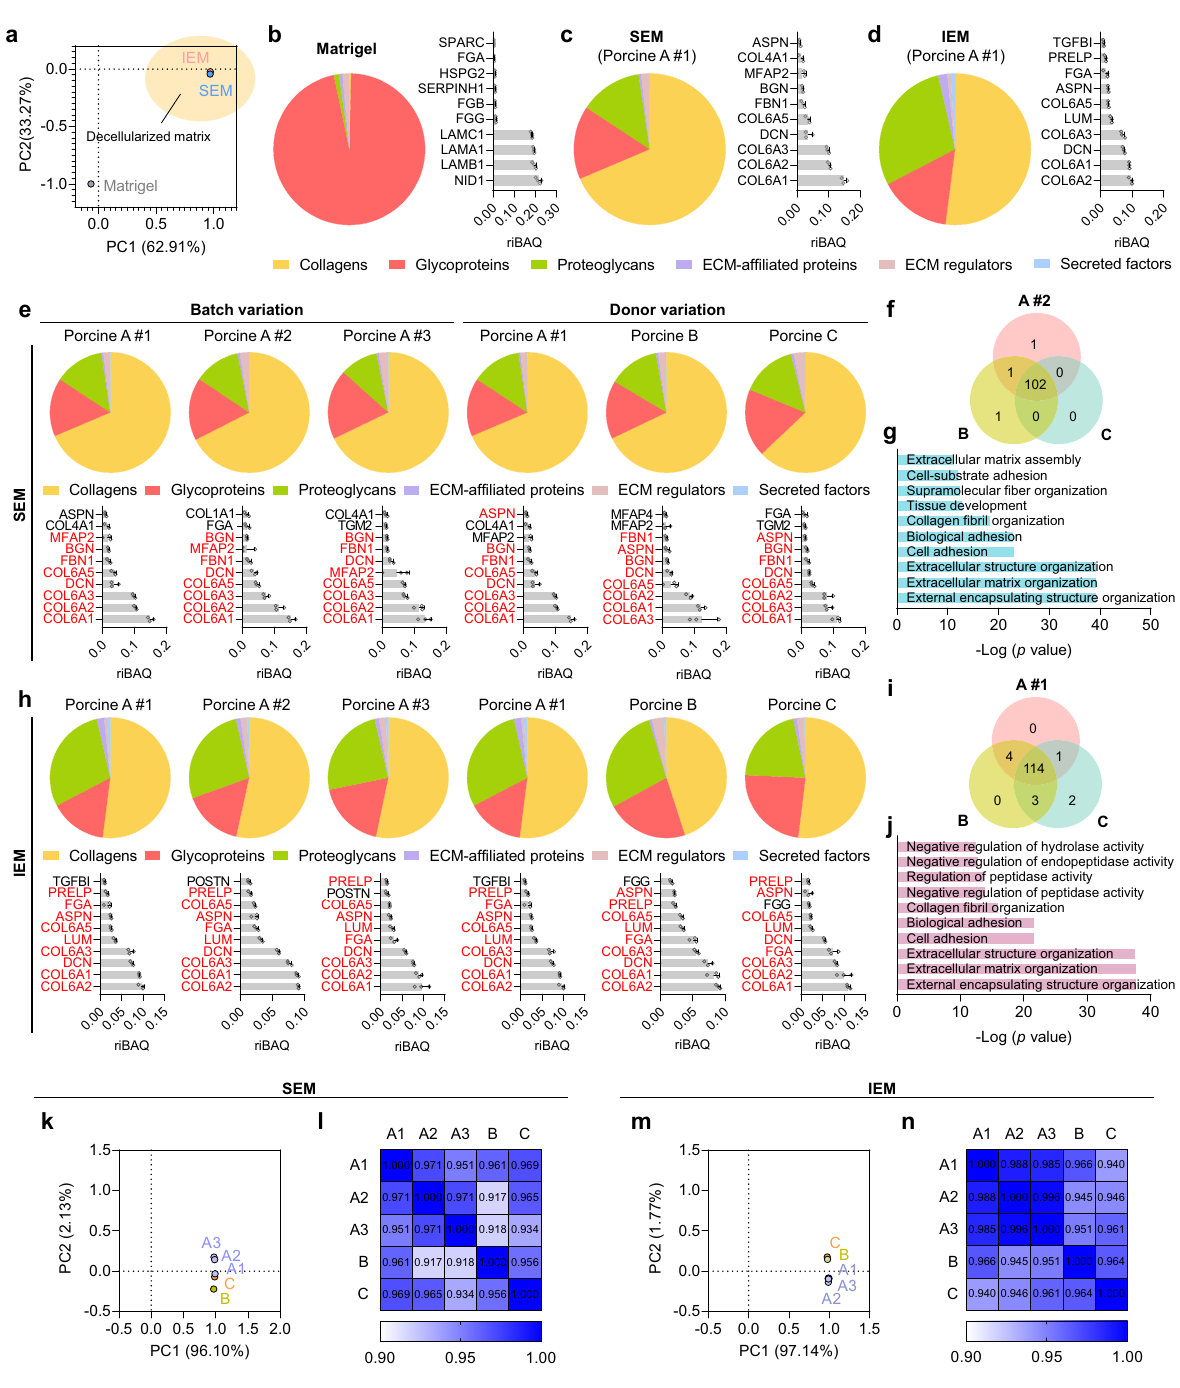
Fig. 2 Proteomic analysis of GI tissue-derived ECM hydrogels. a Principal component analysis (PCA) of matrisome proteins present in Matrigel, SEM, and IEM. The composition of total matrisome proteins and the most abundant top 10 matrisome proteins in b Matrigel, c SEM, and d IEM ( N = 4 for Matrigel and N = 3 for SEM and IEM). Comparison of the composition of total matrisome proteins and the top ten matrisome proteins with the highest expression in e SEM samples and h IEM samples derived from different tissue batches of the same donor (porcine A1 – A3) or different donor batches (porcine A – C) ( N = 3). Venn diagram showing the overlap of matrisome proteins in f SEM samples and i IEM samples derived from three different donors (porcine A – C). GOBP analysis of overlapped matrisome proteins in g SEM samples and j IEM samples from different donor batches. PCA analysis and Pearson ’ s correlation analysis to assess the similarity of total proteins detected in k , l SEM samples, and m , n IEM samples derived from different tissue batches of the same donor (porcine A1 – A3) and different donor batches (porcine A – C). Pearson ’ s correlation coef fi cient values are indicated in each box. The averaged values from three biological replicates were used for analysis in ( f ), ( g ), ( i ), ( j ), and ( k – n ). The data in ( b – d ), ( e ), and ( h ) are presented as mean ±